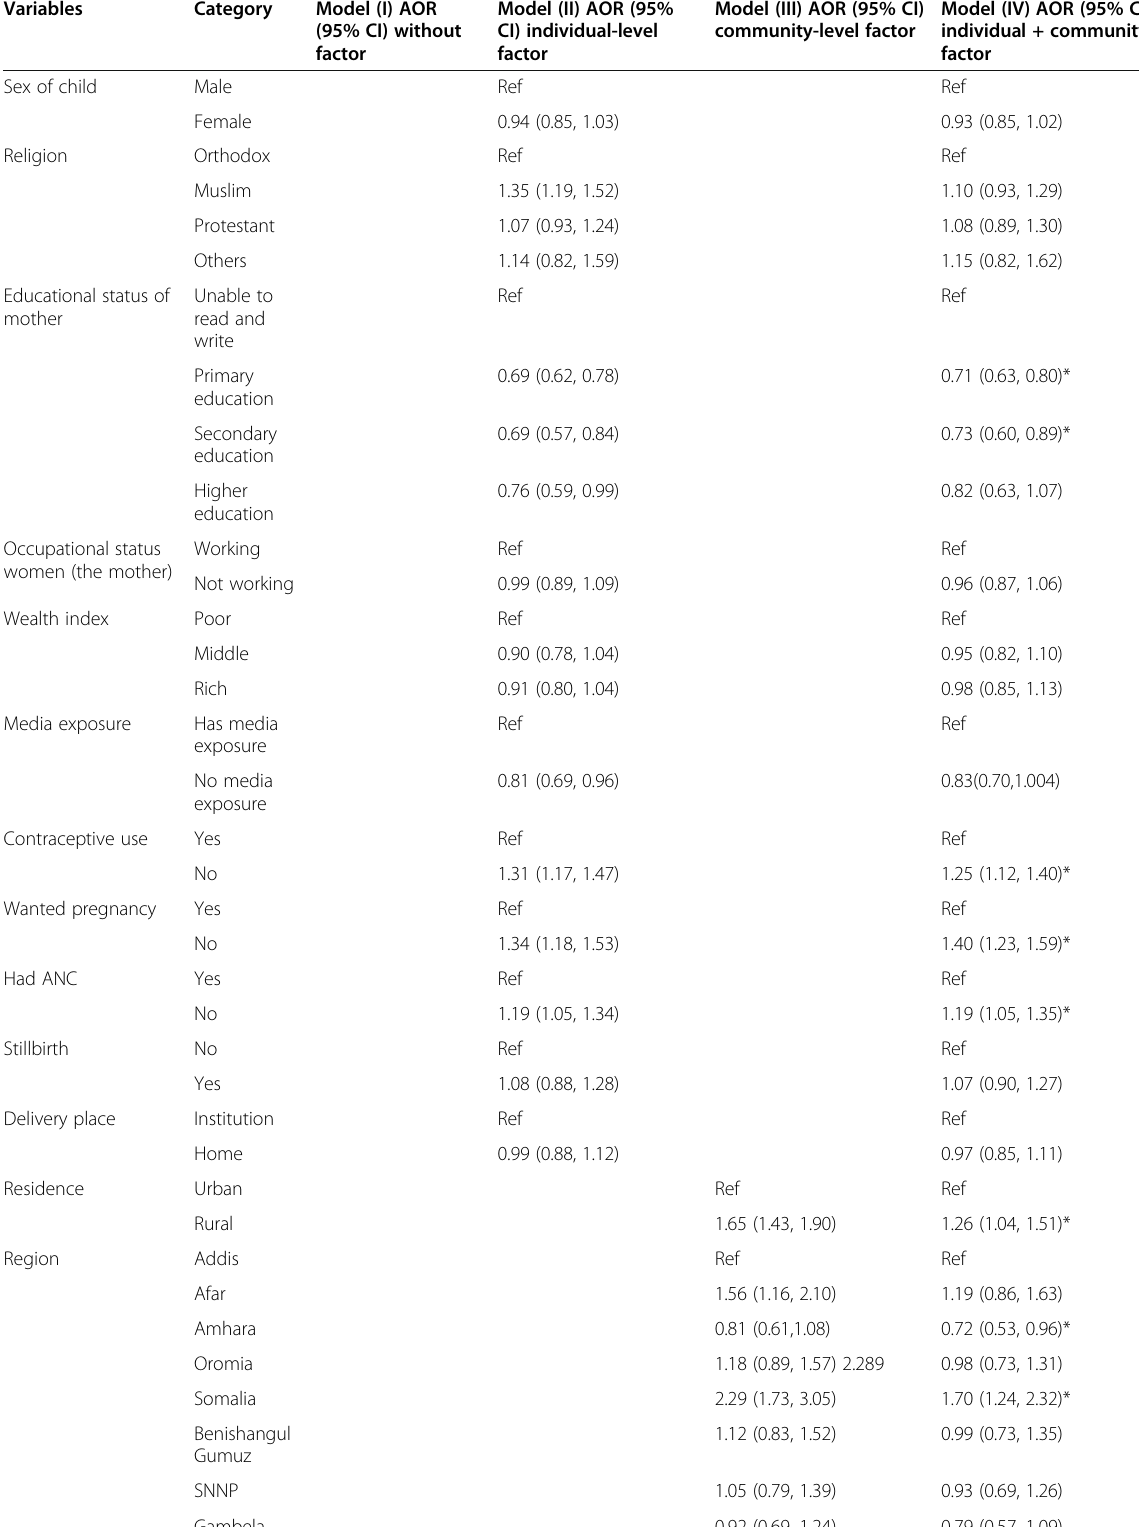
Table 3 Multilevel logistic regression analysis of high-risk fertility behavior among reproductive-age women in Ethiopia, 2016 ( n =